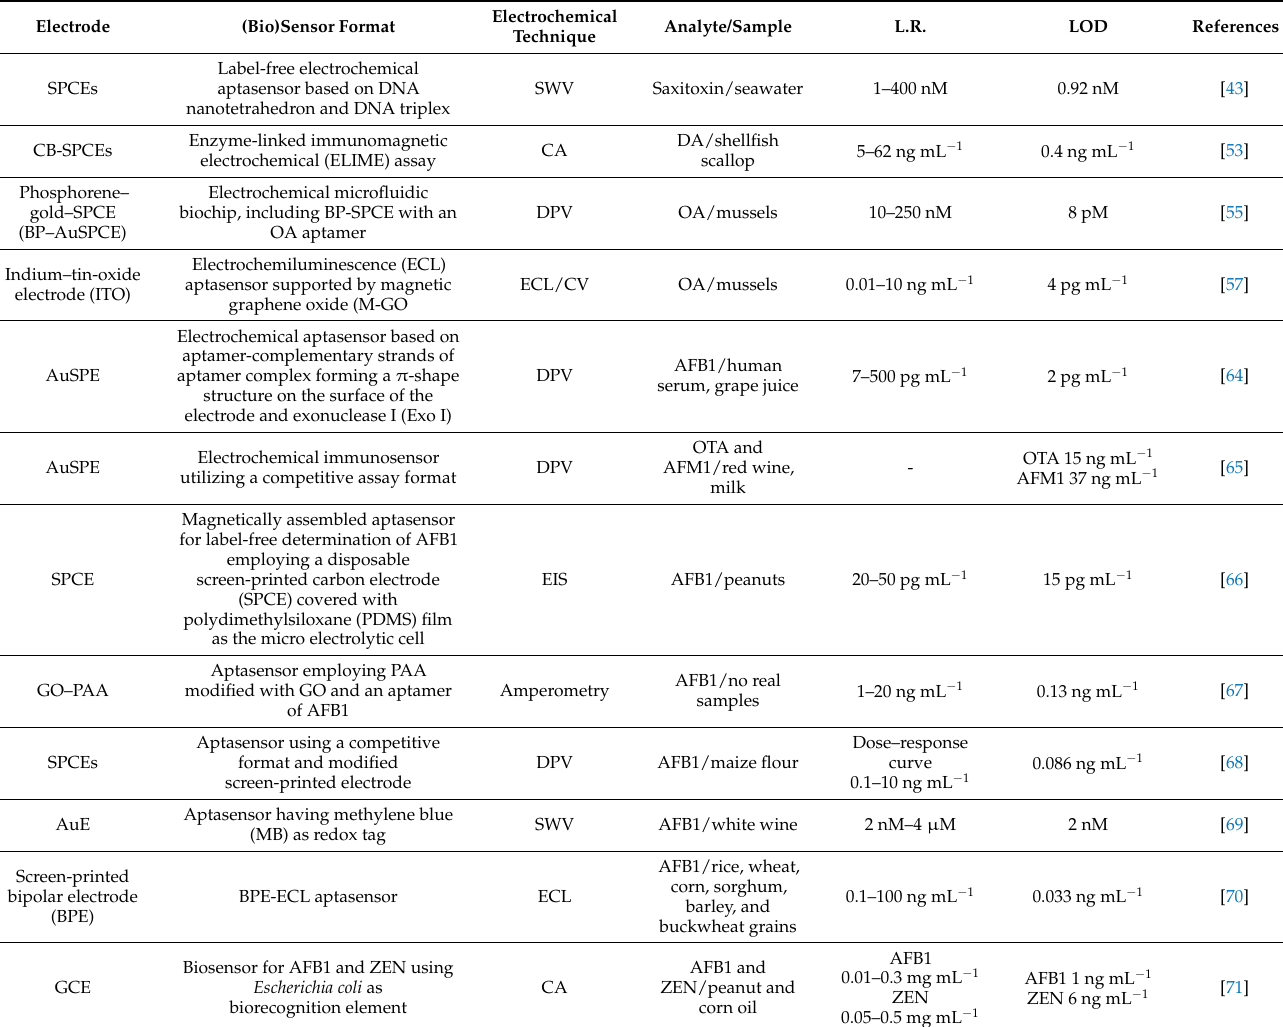
Table 1. An overview of recent electrochemical biosensors for toxins